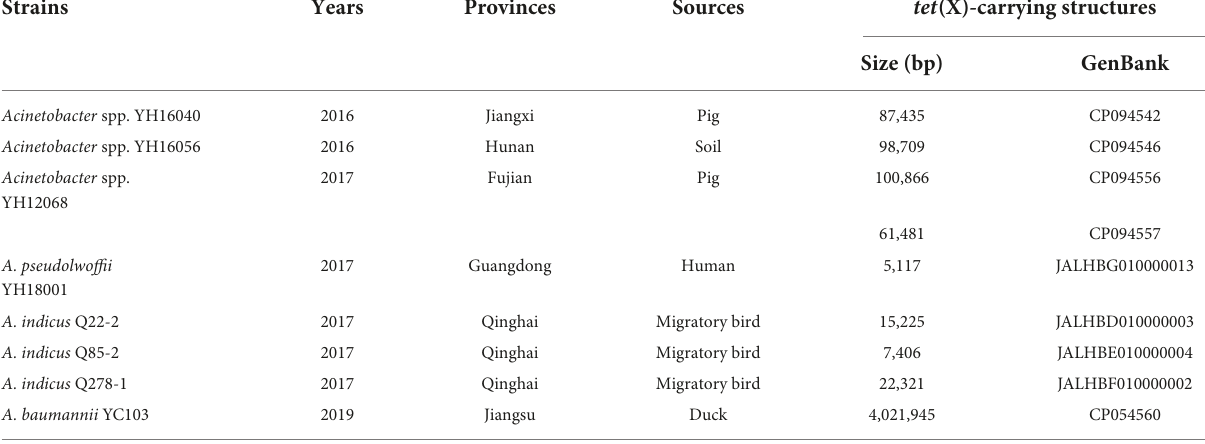
TABLE 1 Bacterial information of tet (X)-positive Acinetobacter spp. isolates by WGS.